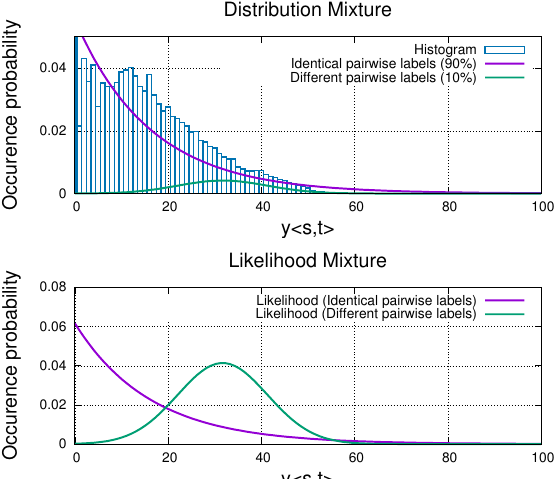
Figure 2. From top to bottom. Top: histogram of y < s , t > obtained on the first frame of the DB-ECSSD database [21,68] (see Figure 1) and distribution mixture estimated by the ICE procedure (see Section 2.4) with an exponential distribution for the id class label and a Gaussian distribution for the di entical fferent pixel-pairwise label. Bottom: likelihood mixture composed of the two previous conditional likelihood distributions P id ( y < s , t > ) and P di ( y < s , t > ) (without weighting proportion) used in the likelihood part of the posterior density of our MRF SD